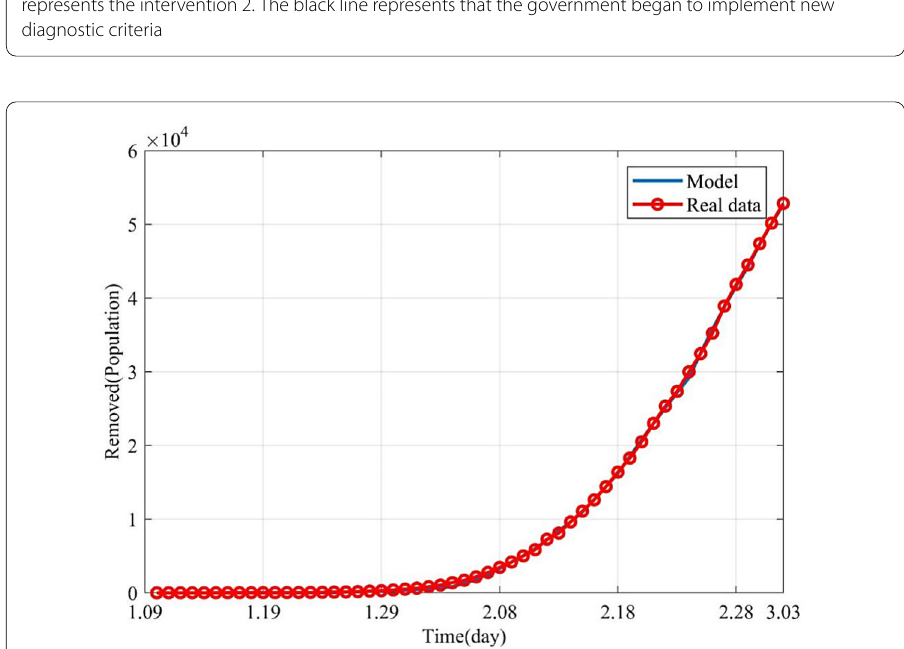
Figure 5 Dynamic trends of the removed. The removed consist of the cures and the death. The blue line represents the simulation of SEIR model. The red line represents the data issued by